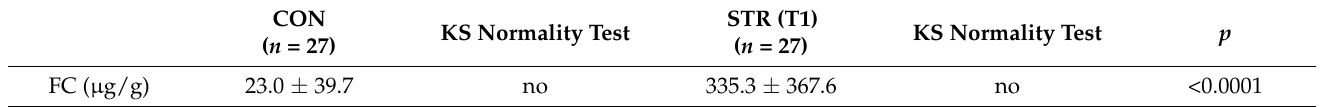
Table 4. Fecal calprotectin concentrations of healthy controls and stroke patients.